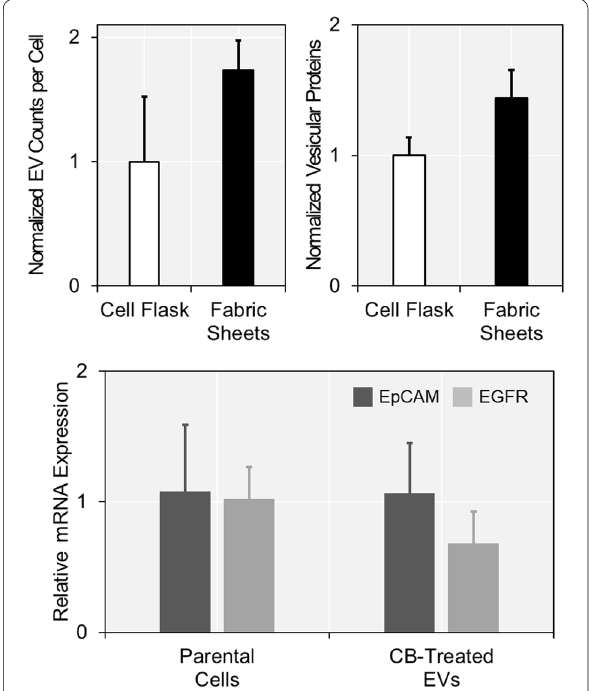
Fig. 4 EVs obtained from cells captured on the fabric filters: a , b the cells on the fabric filters produced more EVs and vesicular proteins, compared to those on the cell culture flasks. c EpCAM and EGFR mRNA expressions were detected from CB‑induced EVs as well as their parental